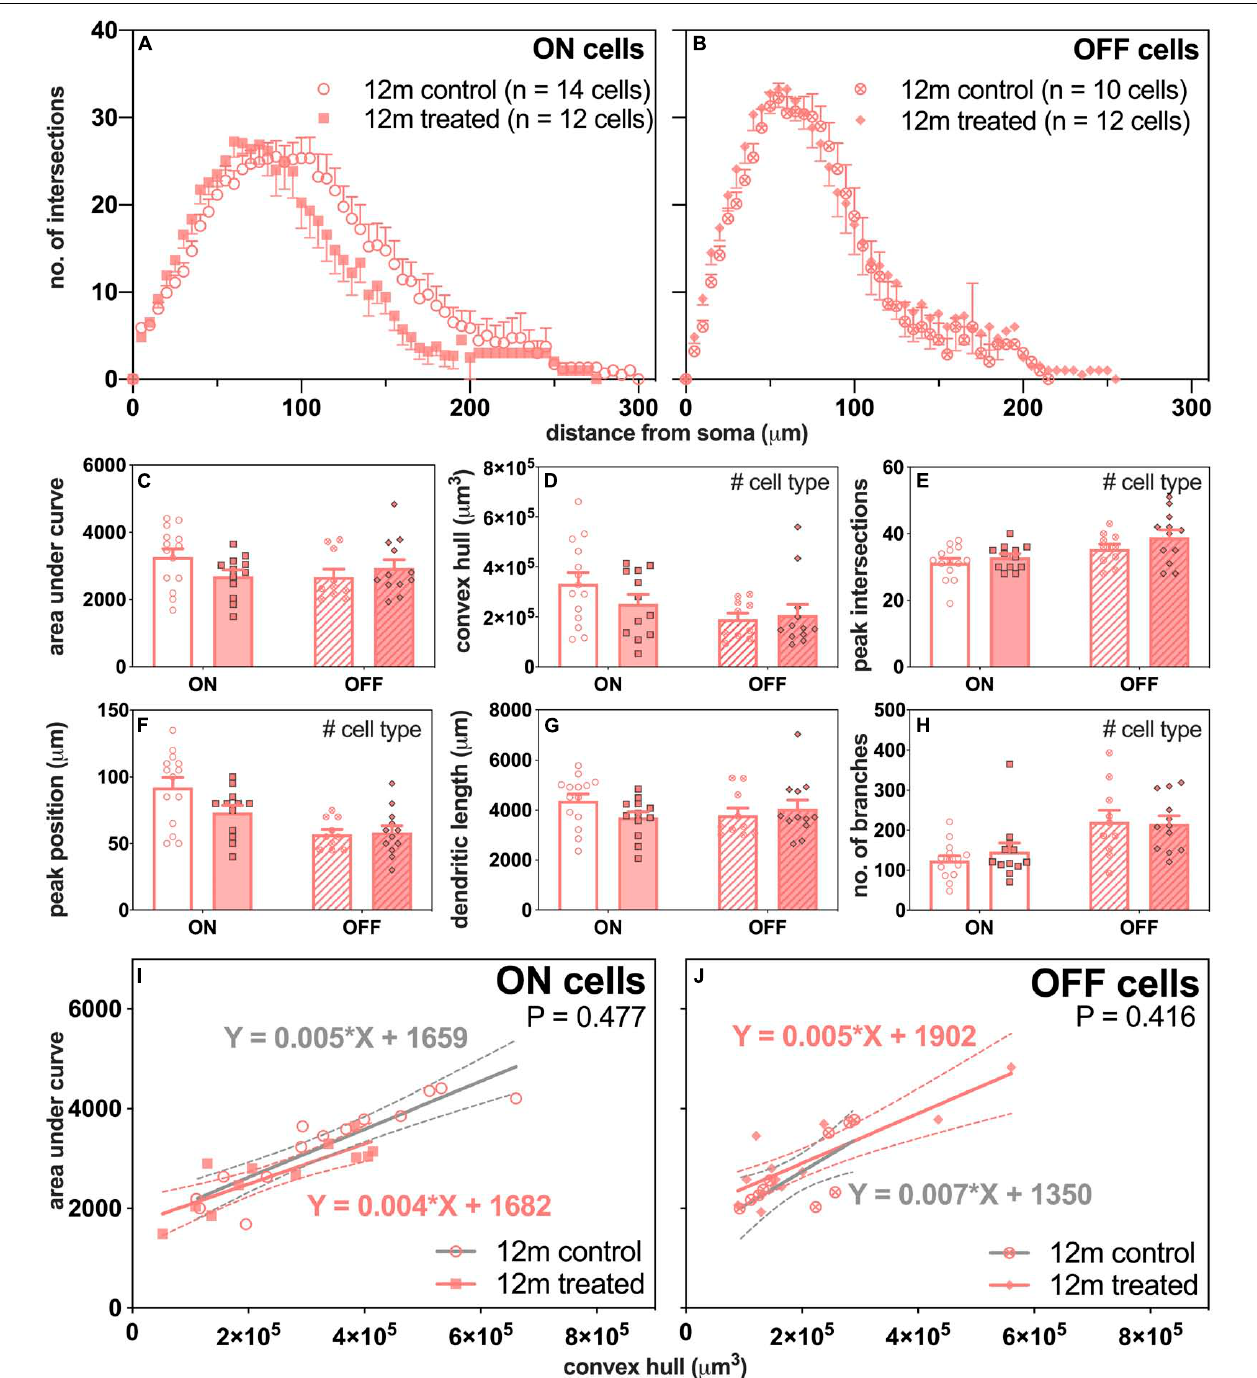
FIGURE 7 | Morphological assessment of ON and OFF RGCs in 12-month-old control and IOP-treated eyes 7 days after IOP elevation. (A,B) Sholl profiles displaying group averaged dendritic complexity (no. of intersections) relative to distance from soma in (A) ON [control, unfilled circles, n = 14 cells (3 animals); treated, filled squares, n = 12 cells (4 animals)] and (B) OFF [control, crossed circles, n = 10 cells (4 animals); treated, filled diamonds, n = 12 cells (4 animals)] RGCs. (C) Area under curve for control (unfilled bars) and IOP-treated (filled bars) of ON (solid bars) and OFF (patterned bars) RGCs. (D) Convex hull volume (# p = 0.024). (E) Peak number of intersections (# p = 0.007). (F) Peak position (# p < 0.001). (G) Total dendritic length. (H) Total number of branches (# p < 0.001). (I,J) Dendritic complexity (area under curve) with respect to cell size (convex hull volume) in (I) ON and (J) OFF RGCs. Error bars, SEM; #, mixed effects model p < 0.05; solid line, linear regression; dashed line, 95% confidence interval; p -value, statistical significance of difference in